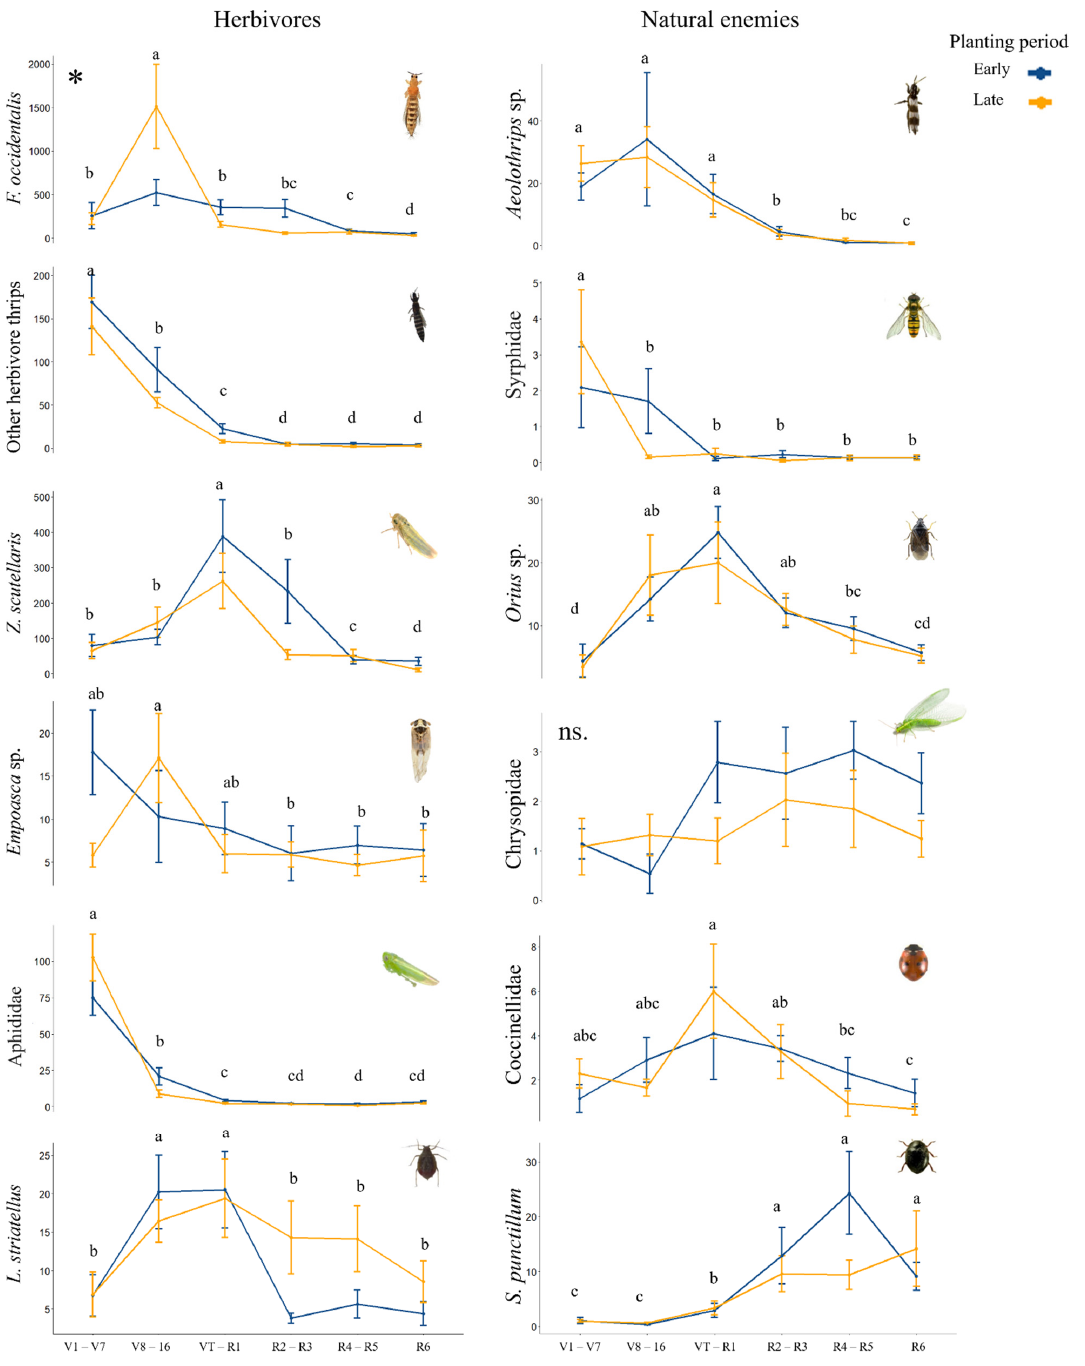
Figure 2. Insect abundance according to maize phenology for all years in each planting period (early and late) with the mean and standard deviation. The letters show significant differences ( p < 0.05) among phenologies. Asterisks indicate that there are differences between planting periods. Chrysopidae show non-significant (ns) results. (More details in Supplementary